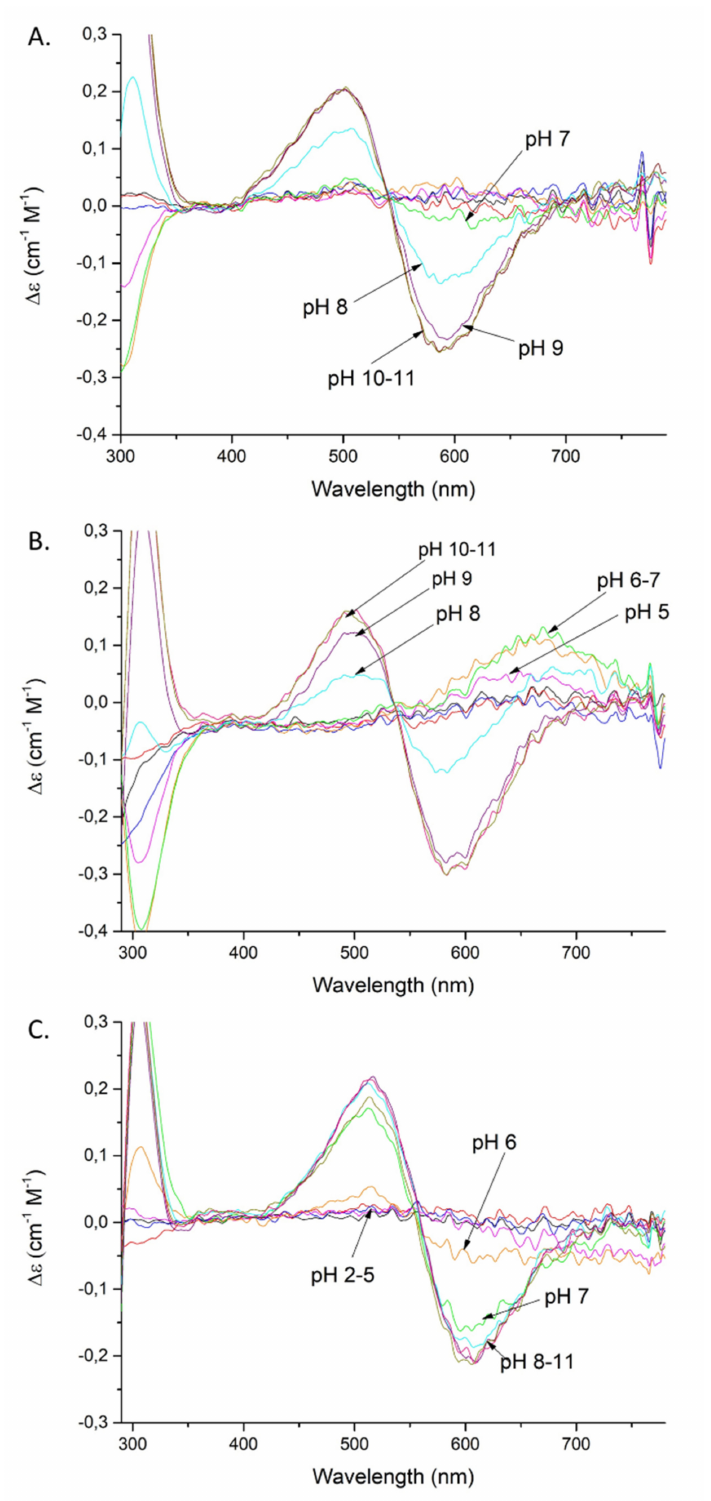
Figure 3. CD spectra of Cu(II) complexes with: SAAP2 ( A ); SAAP3 ( B ); SAAP6 ( C ); over the pH range 2–11. Conditions: T = 298 K, 0.1 M NaClO 4 , [Cu(II)] = [SAAP2] = [SAAP3] = [SAAP6] = 1.0